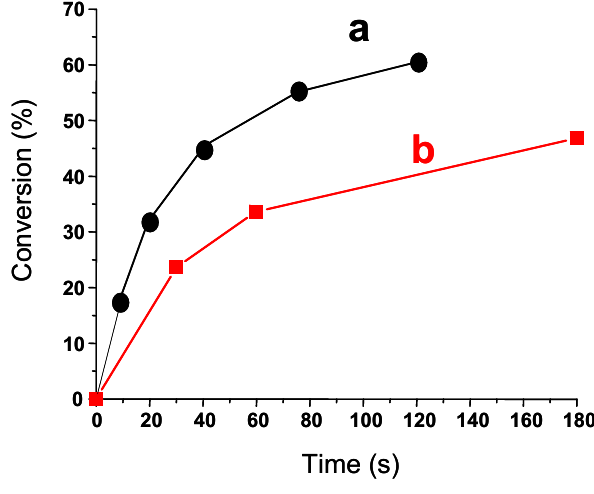
/(TMS) Si- 3 3 2+ /(TMS) Si-H/Ph I + 3 3 2